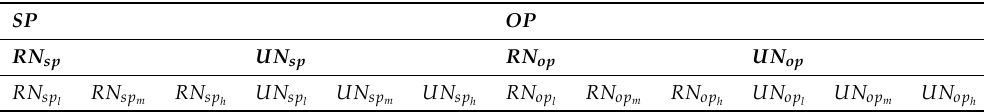
Table 2. Parts of SP and OP